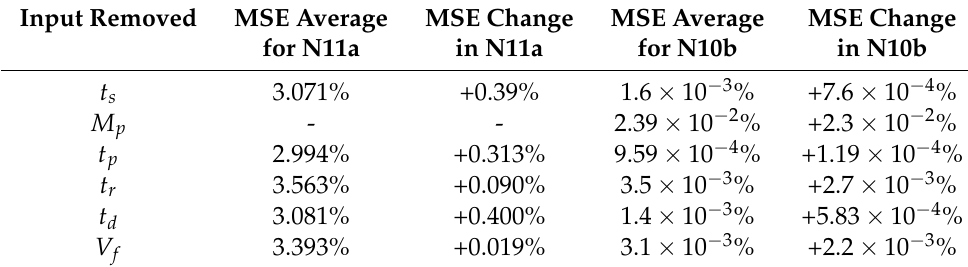
Table 5. Test for validation of the inputs of the